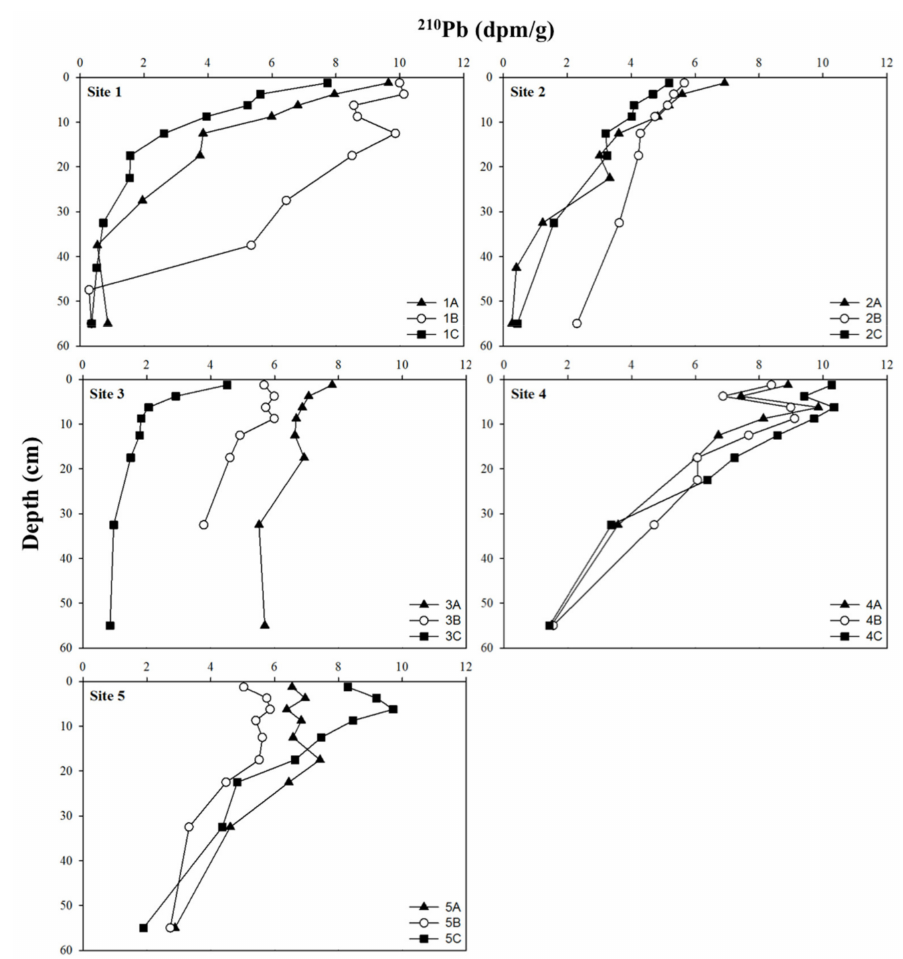
Figure 4. Lead-210 profiles for each site along the estuarine gradient of the Nanticoke